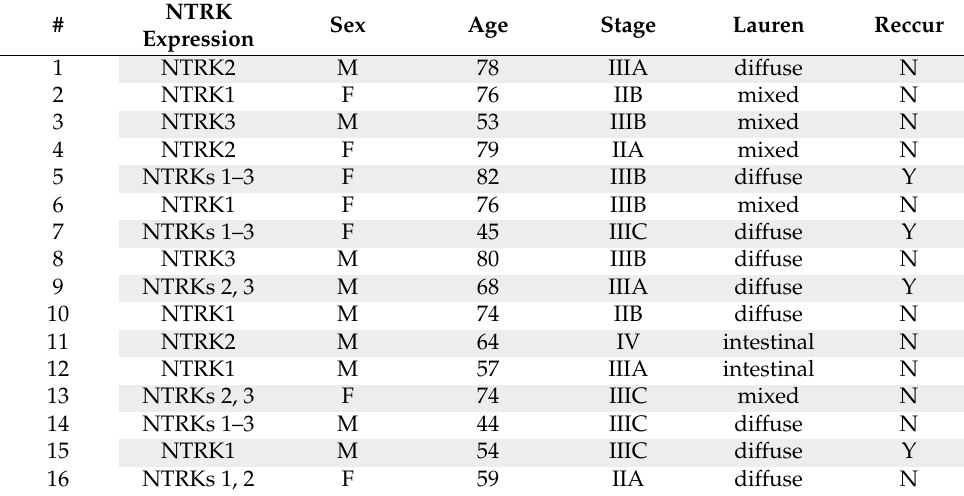
Table 1. The characteristics of patients with NTRK overexpression ( n = 16).